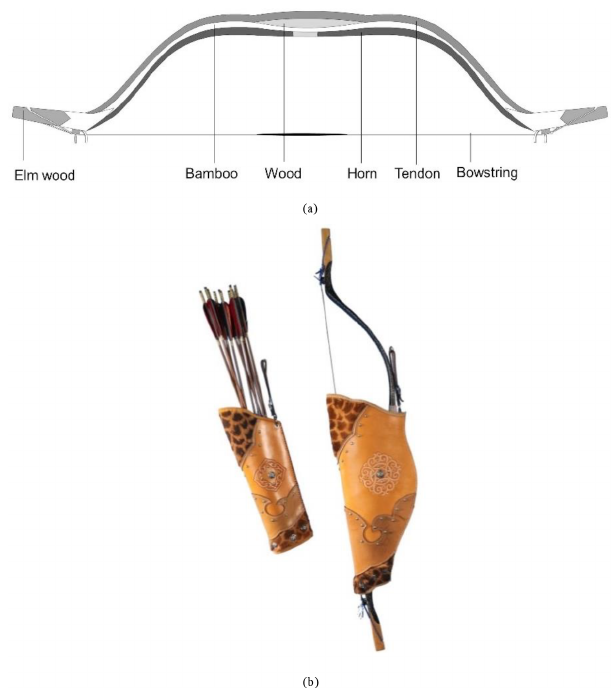
Figure 1. Mongolian traditional bow (provided by Nuo Min,